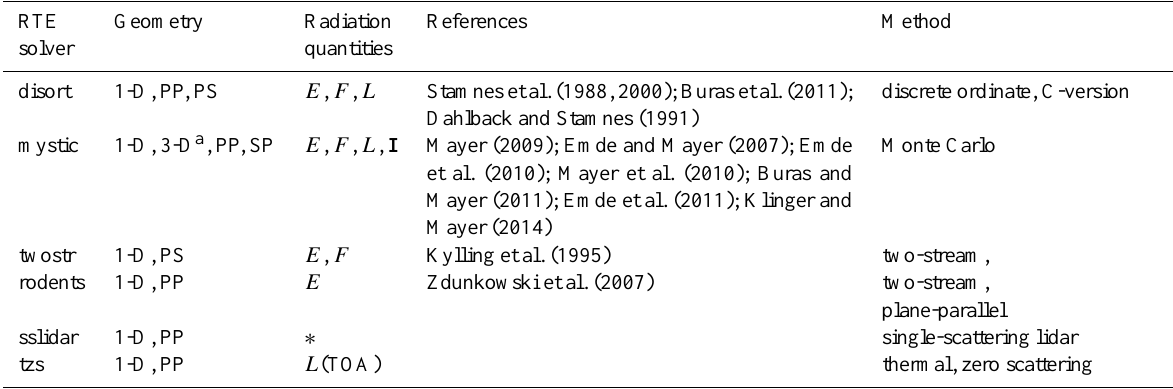
Table 1. The radiative transfer equation solvers currently implemented in